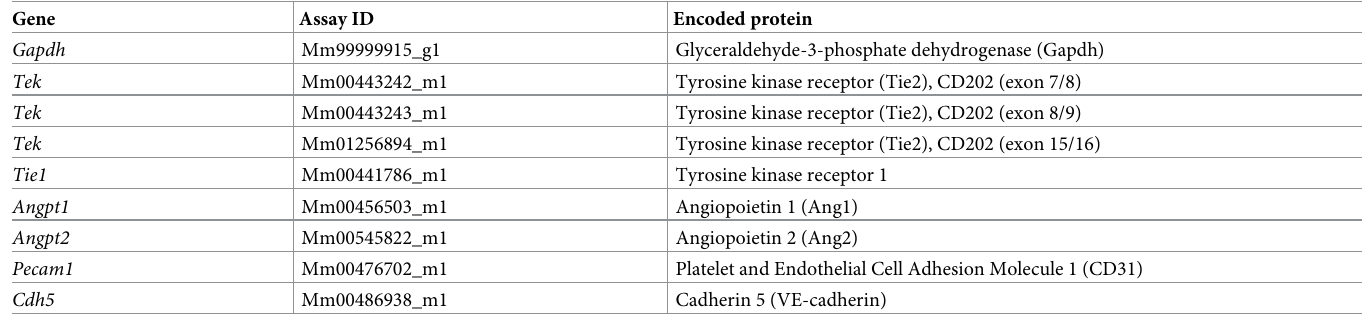
Table 1. RT-qPCR